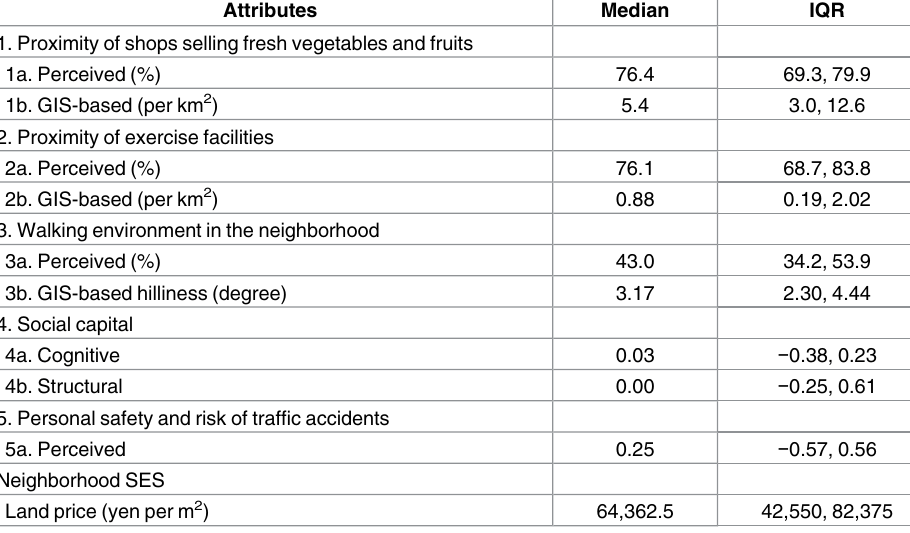
Table 2. Basic attributes of the neighborhood environment in the study locations in Chita peninsu- lar, Aichi Prefecture, Japan (n =